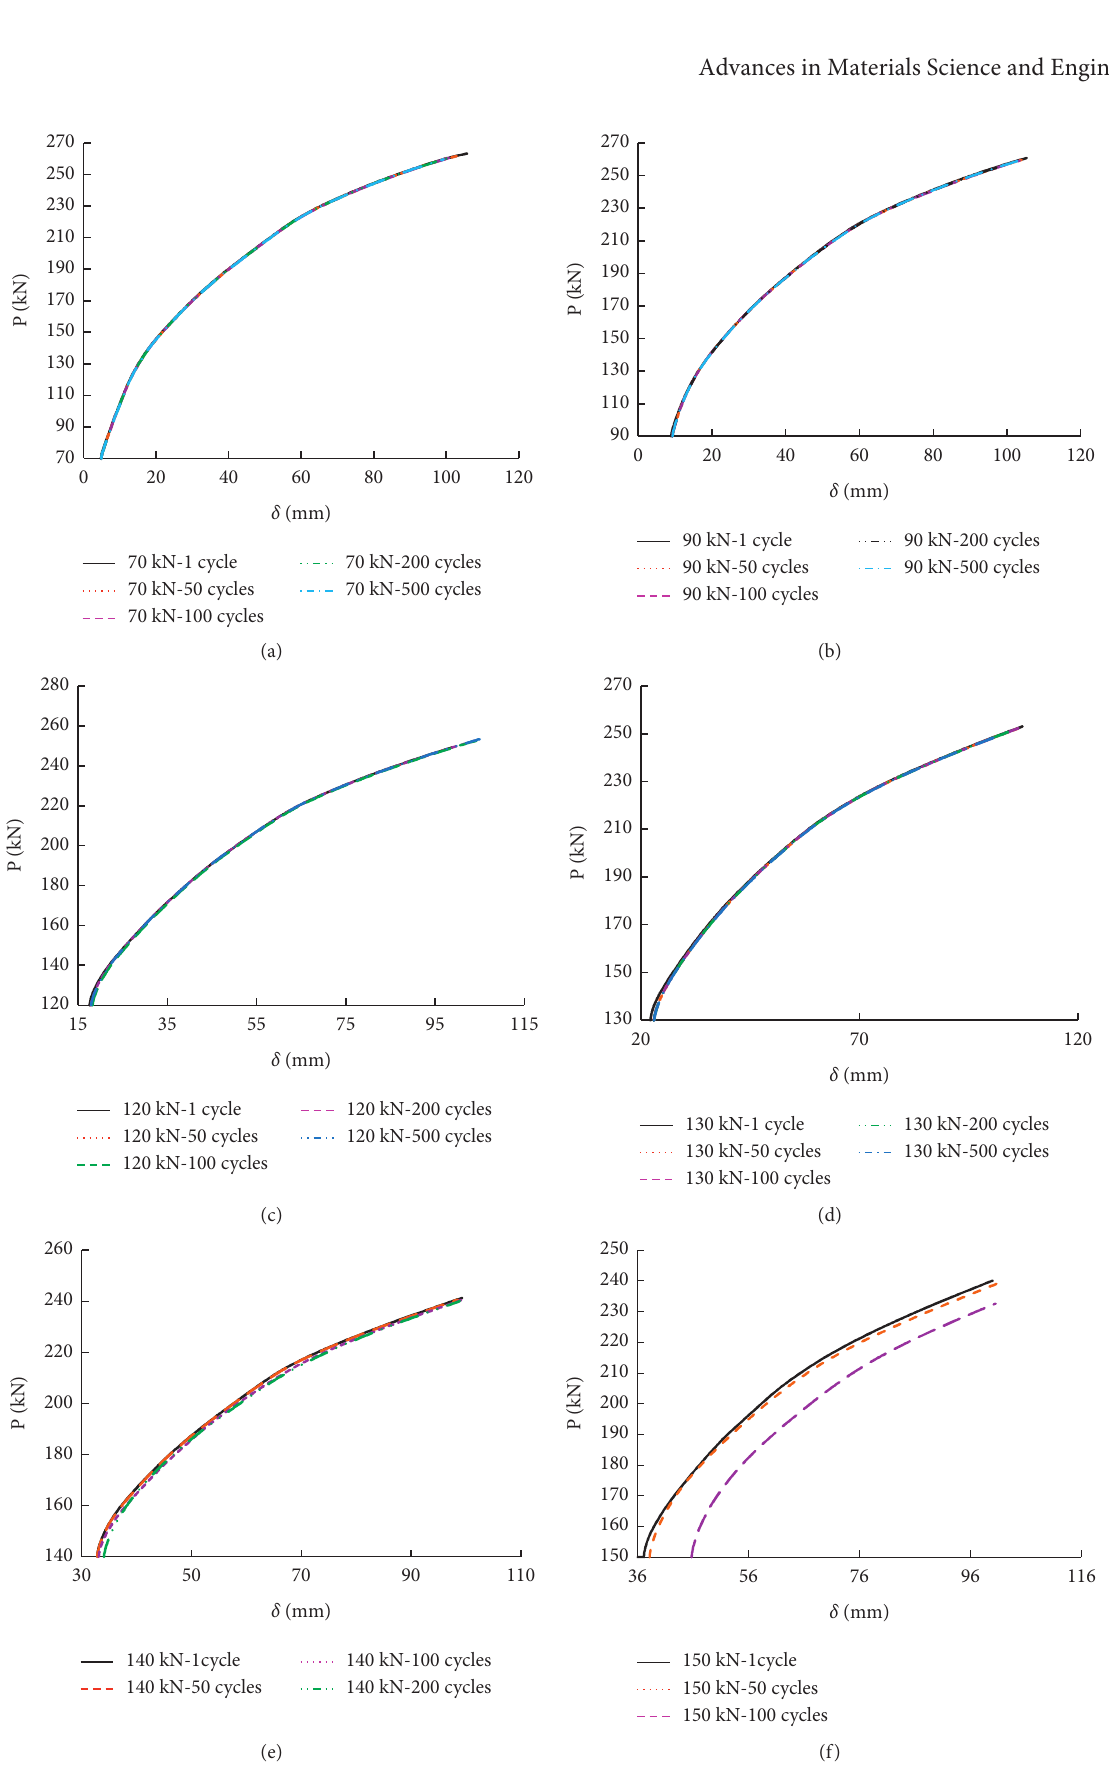
Figure 11: Load-deformation curves of different cycle numbers: (a) overload amplitude 70kN, (b) overload amplitude 90kN, (c) overload amplitude 120kN, (d) overload amplitude 130kN, (e) overload amplitude 140kN, and (f) overload amplitude